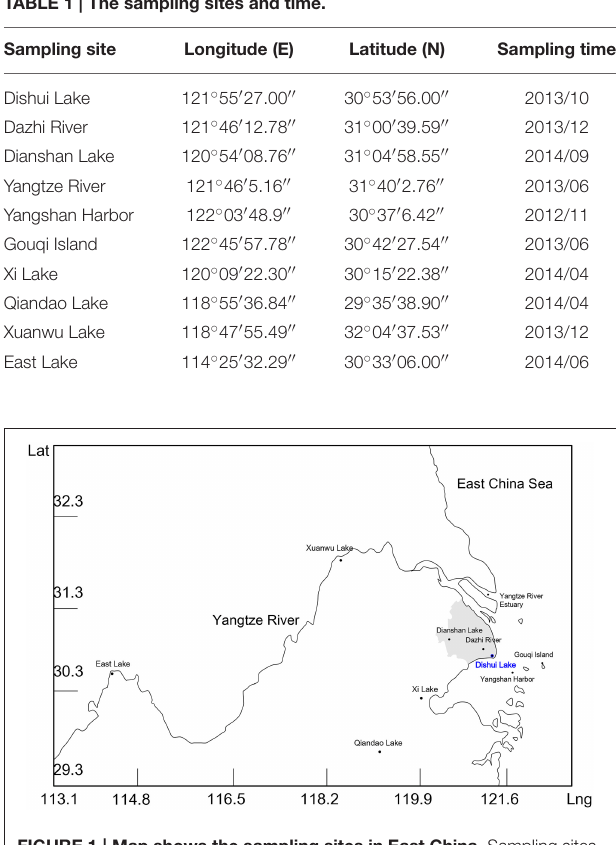
FIGURE 1 | Map shows the sampling sites in East China. Sampling sites are indicated with names and dark dots. Dishui Lake is highlighted in blue. Numbers on horizontal and vertical axis represent longitude (Lng) and Latitude (Lat), respectively. The area of Shanghai is shaded in gray.